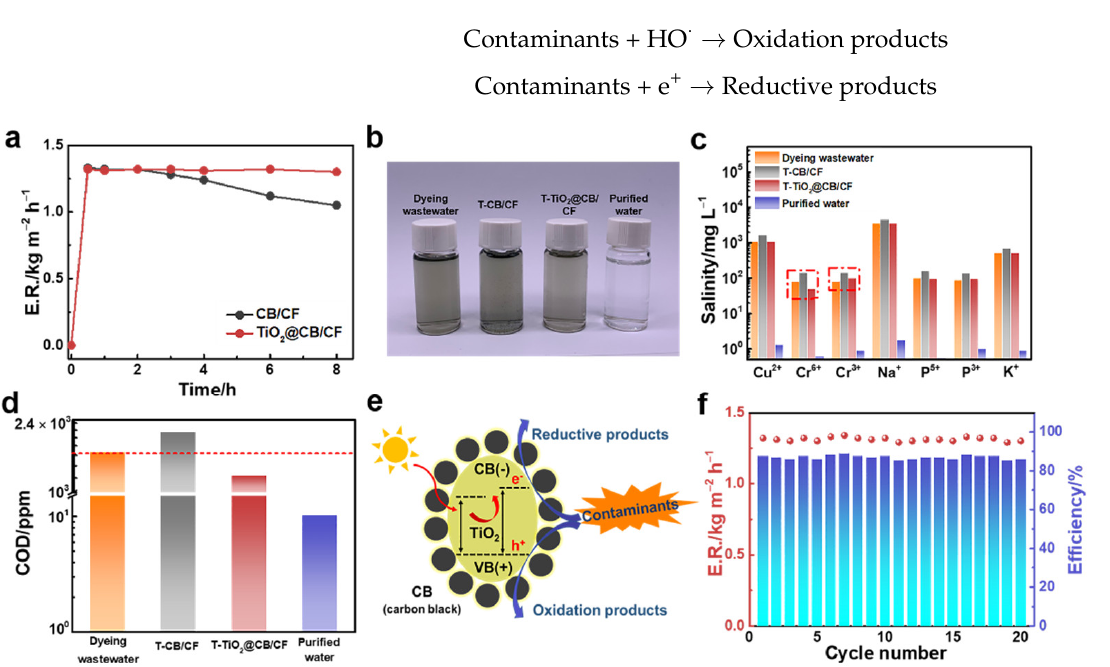
Figure 5. The treatment effect of actual industrial dyeing wastewater with the TiO 2 @CB/CF under one-sun illumination. ( a ) The evaporation rate of the CB/CF and TiO 2 @CB/CF with 8 h. ( b ) Optical images of dyeing wastewater, treatment with CB/CF, treatment with TiO 2 @CB/CF, and purified water. ( c ) The salinity of some ions of the industrial dyeing wastewater treatment with CB/CF, treatment with TiO 2 @CB/CF, and purified water. ( d ) The COD of the industrial dyeing wastewater treatment with CB/CF, treatment with TiO 2 @CB/CF, and purified water. ( e ) The possible photocatalytic effect of TiO 2 @CB/CF for dye degradation. ( f ) A test of the durability of the TiO 2 @CB/CF in the industrial dyeing wastewater.